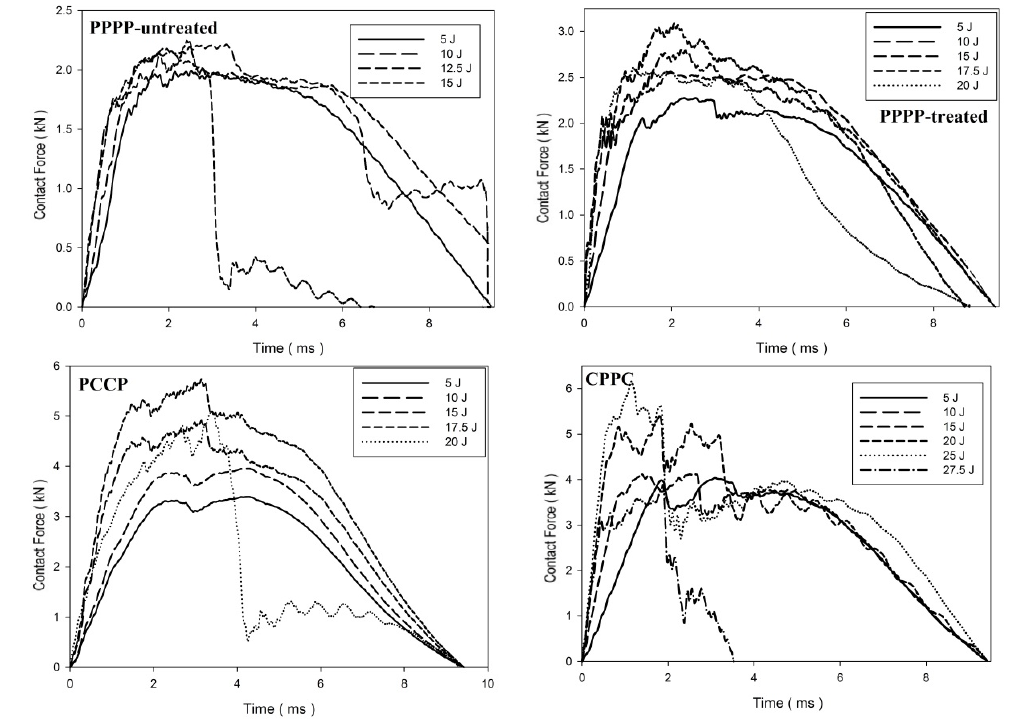
Figure 10. Contact force–time of the hybrid laminates at ply orientations of [±45° 2 , 0° / 90° 2 ] s .